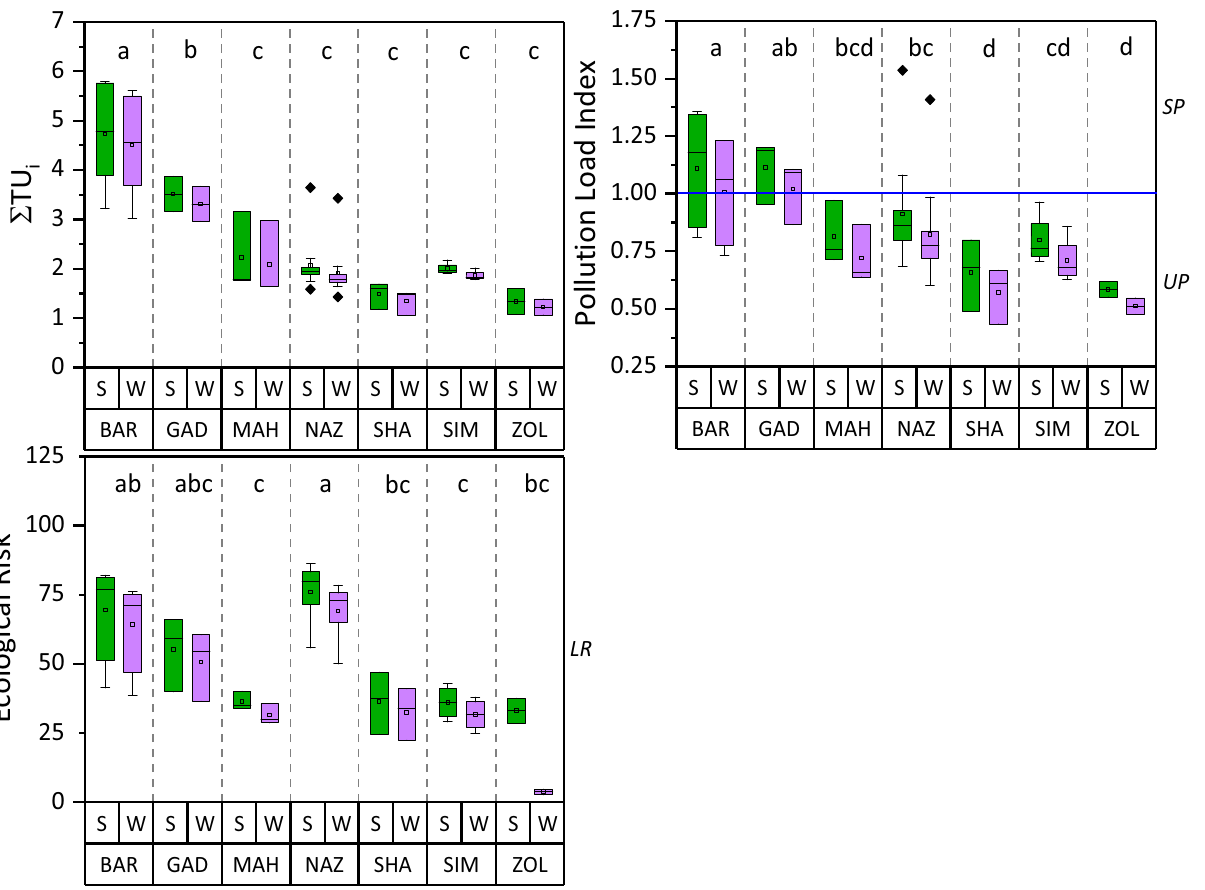
Figure 5. The comparison of the mean pollution load index (PLI), ecological risk (ER), and potential acute toxicity of heavy metals (∑TU) of selected heavy metals during summer and winter in the study rivers’ sediments. Different letters show significant differences in PLI, ER, and ∑TU among rivers pooled over seasons at P < 0.05 confidence level. Horizontal lines demosnstarte the critical levels. UP is “Unpolluted”, SP is “Slightly Polluted”, and LR is “Low Risk”.